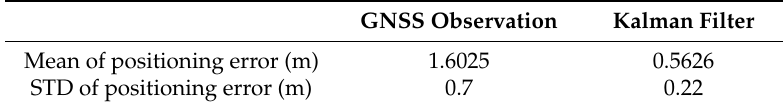
Figure 11. Tracking error. Table 1. Test Occasion 1: Mean and STD of the positioning error for the GNSS Observation and Kalman Filter.